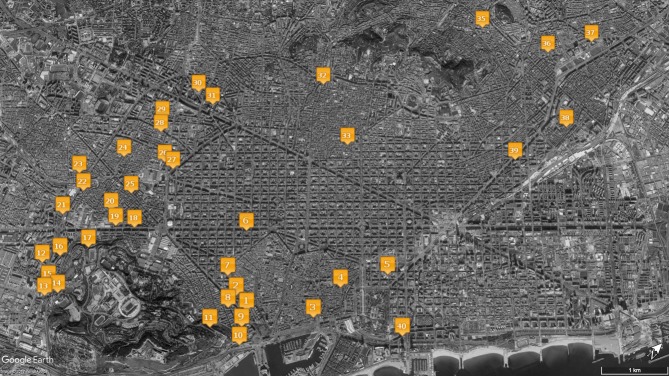
Location map for observed POS.